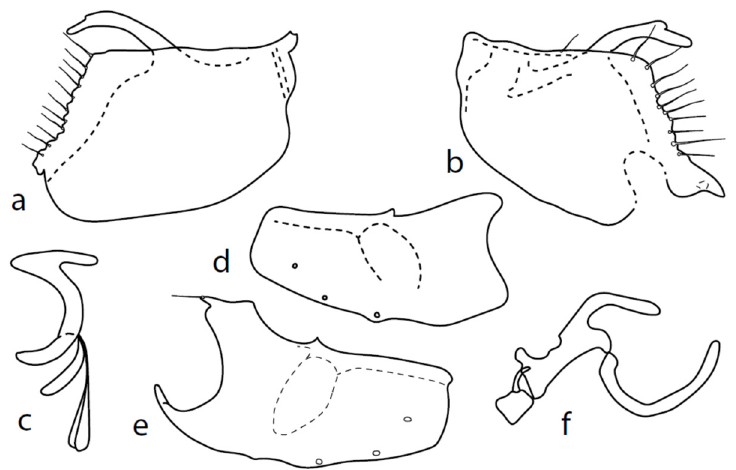
Figure 8. M. crassipes : ( a ) = right epandrial lamella, ( b ) = left epandrial lamella, ( c ) = postgonite from left, ( d ) = hypandrium from left, ( e ) = hypandrium from right, ( f ) = phallus from left. Microphor holosericeus (Meigen, 1804)